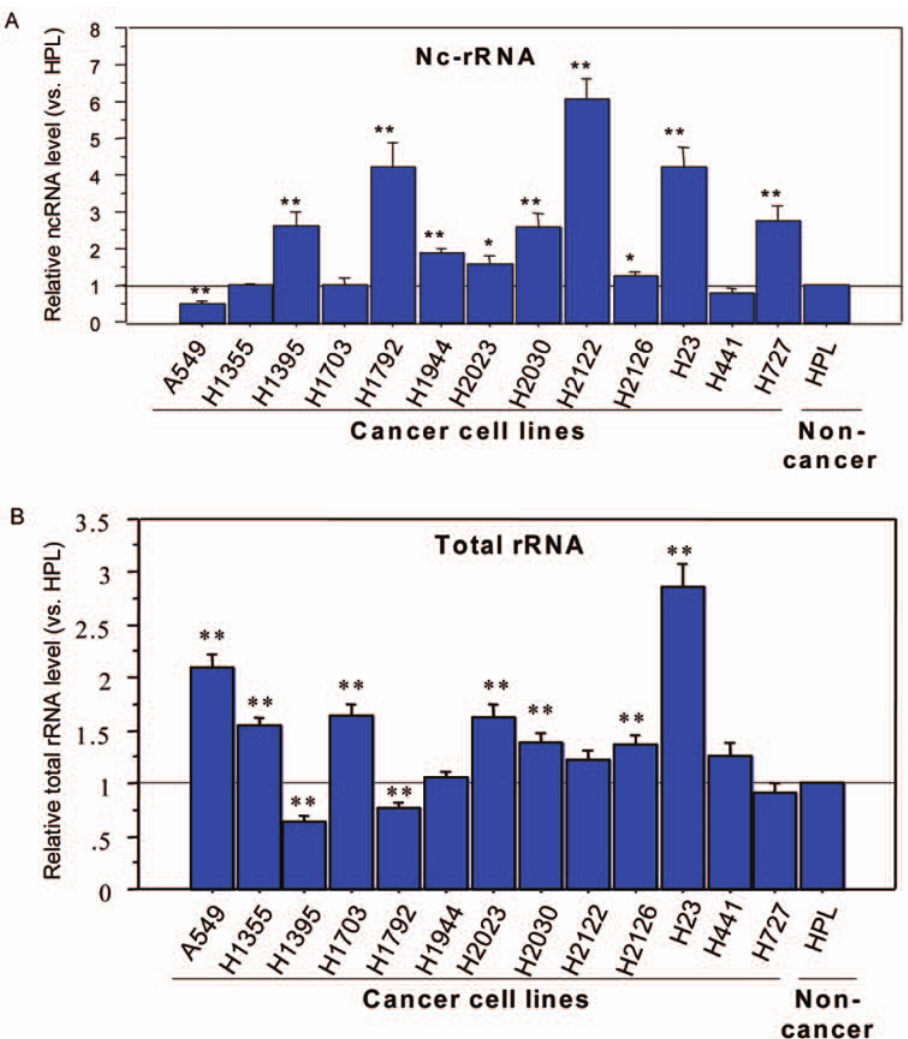
Figure 3. Average levels of nc-rRNA from 7 RT-PCR repeats (A) and 45S rRNAs from 9 repeats (B) in a series of transformed human lung cancer cell lines compared to the non-cancerous HPL cell line. * P , 0.05, ** P , 0.01, significantly different from non-transformed HPL cells. For 45S rRNA, apparent increases were of borderline significance for H2122 (p=0.062) and for H441 (P=0.0595).